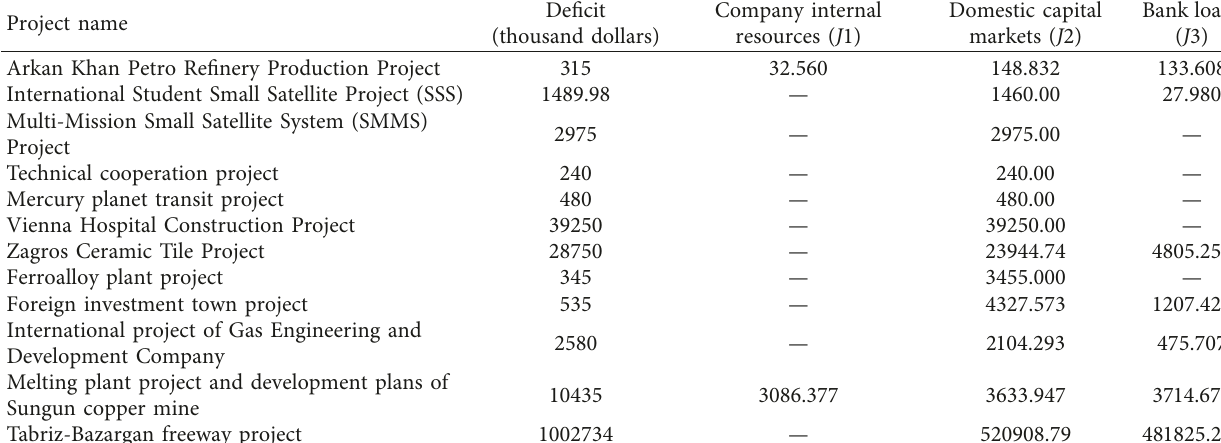
Table 13: Amount of financing performed using NSGA II algorithm.